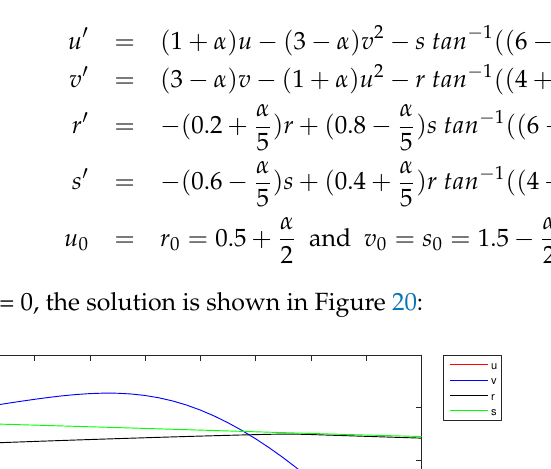
Figure 19. The solution of (10) at α = 1. 2.